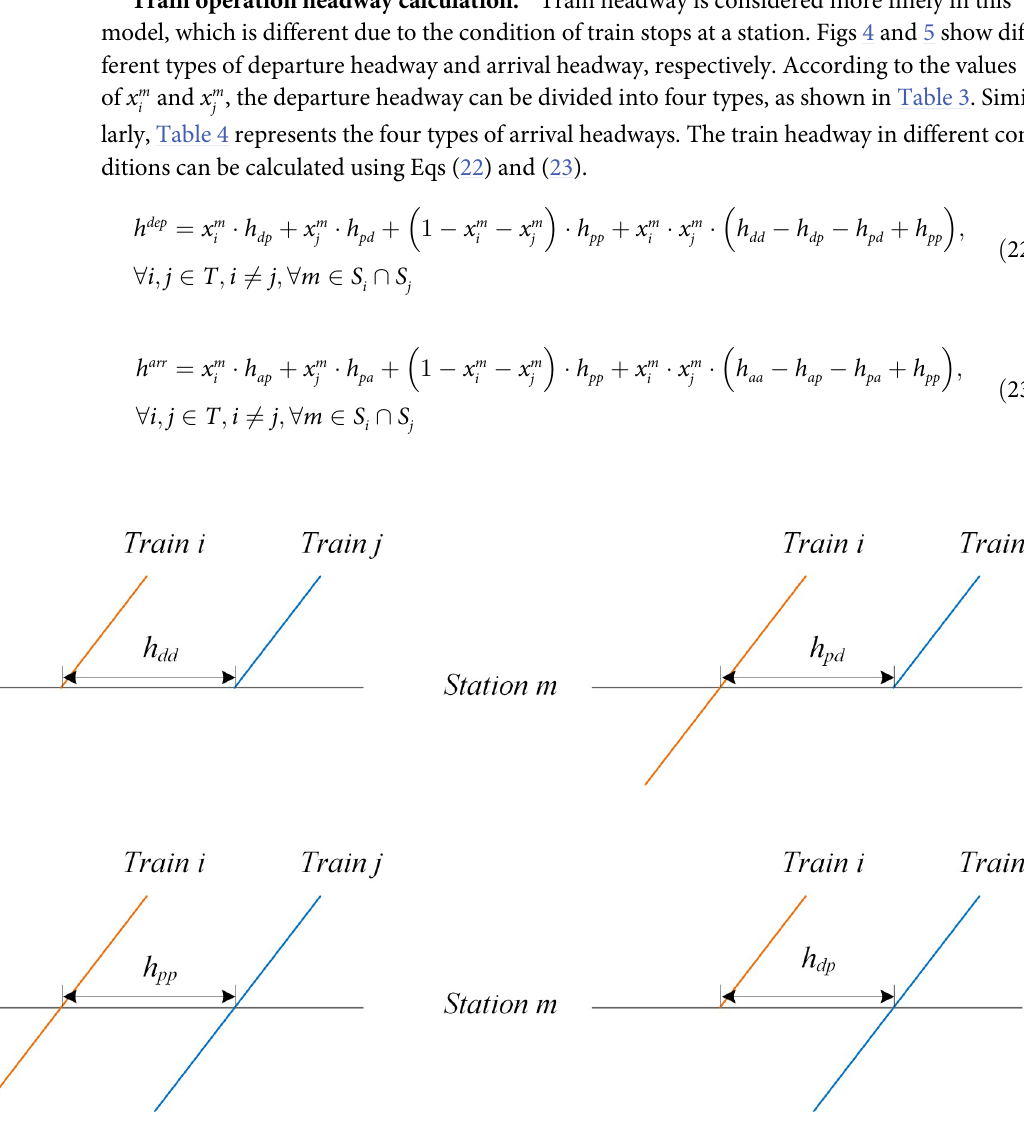
Fig 4. Departure headway in different situation of train